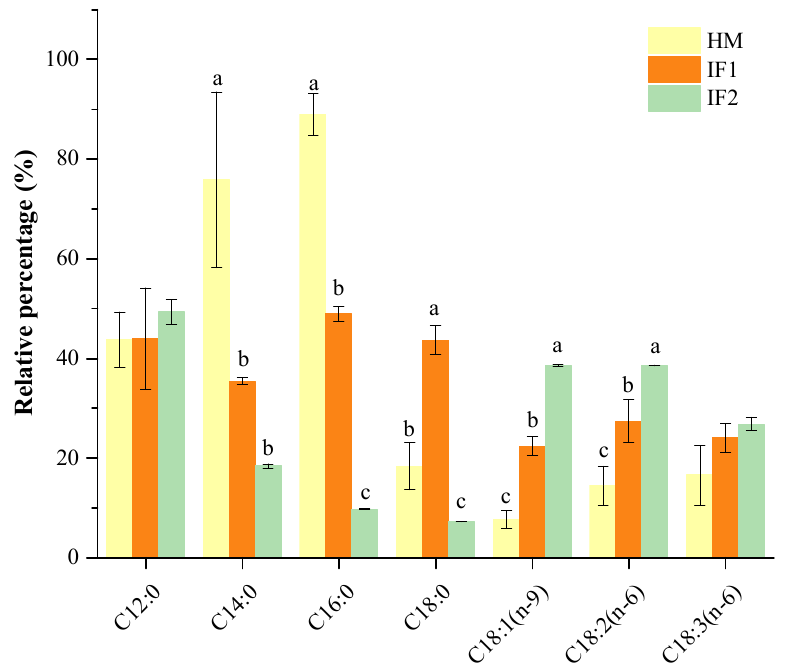
Figure 1. Percentage of relative sn -2 position fatty acids. Different lowercases indicate significant differences among samples. HM, human milk; IF, infant formula.